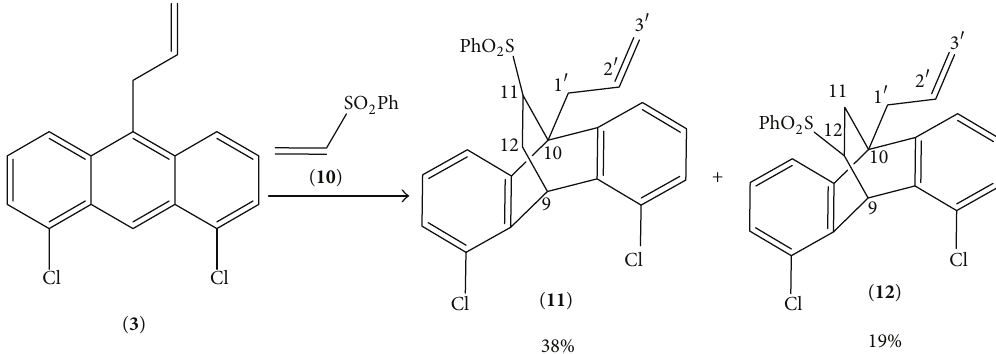
Scheme 3: The Diels-Alder cycloaddition of phenyl vinyl sulfone ( 10 ) with 10-allyl-1,8-dichloroanthracene ( 3